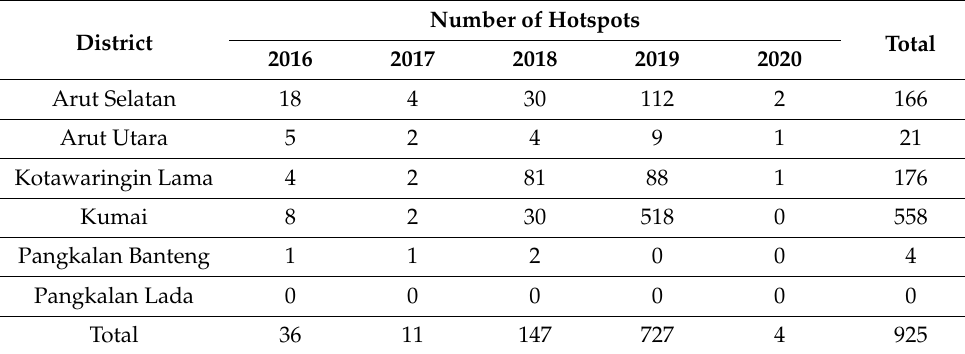
Table 2. Number of hotspots per